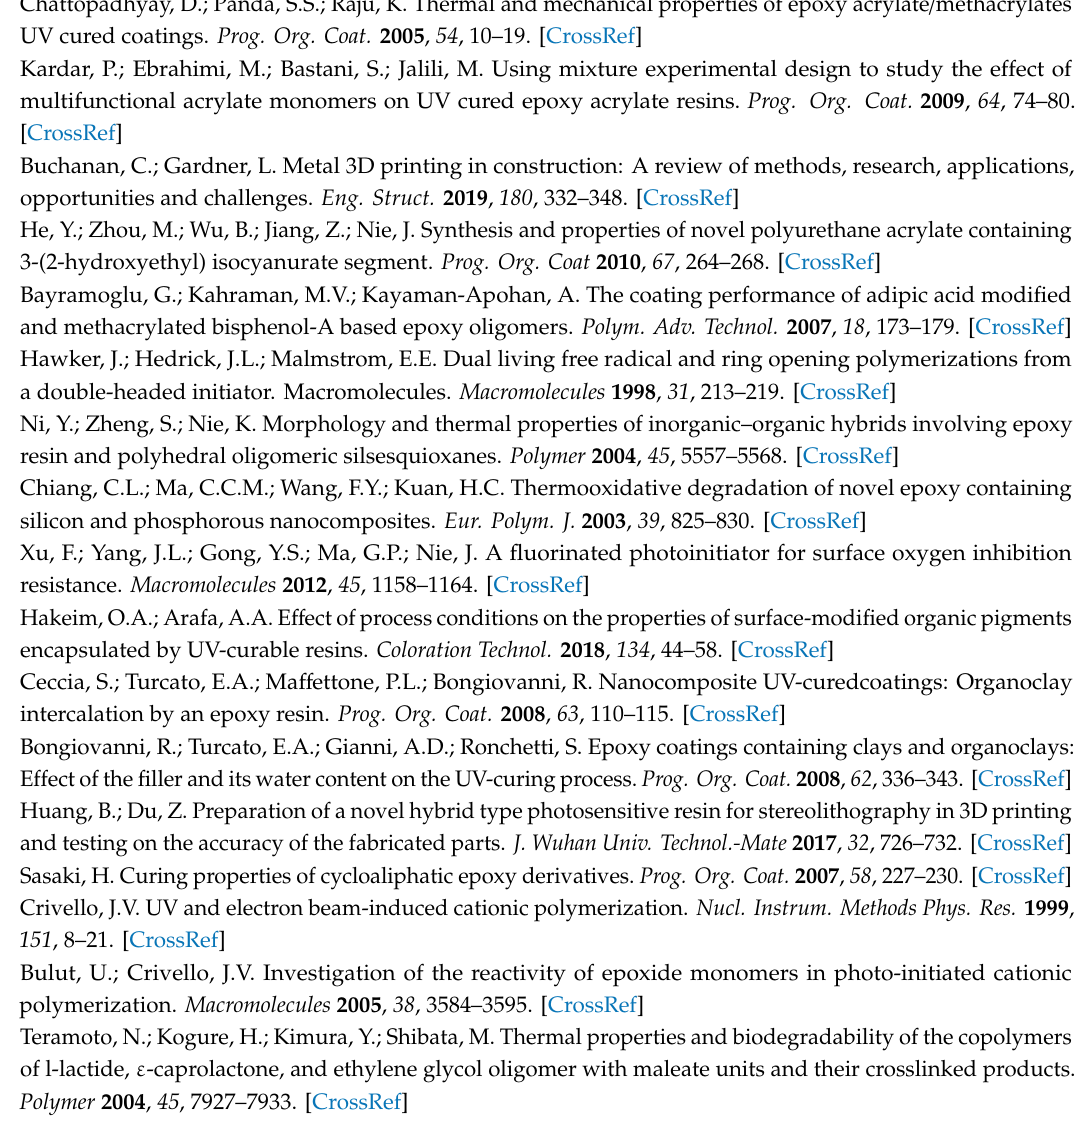
Figure S1 Heat flux maps of the spline at 80 ◦ C; Figure S2 Heat flux maps of the spline at 100 ◦ C; Figure S3 Heat flux maps of the spline at 150 ◦ C; Figure S4 Temperature map of the spline with heat treatment at 80 ◦ C for 22 s; Figure S5 Temperature map of the spline with heat treatment at 100 ◦ C for 22 s; Figure S6 Temperature map of the spline with heat treatment at 150 ◦ C for 22 s; Figure S7 Maximum thermal deformation map of the spline on Y-axis at 80 ◦ C; Figure S8 Maximum thermal deformation map of the spline on Y-axis at 100 ◦ C; Figure S9 Maximum thermal deformation map of the spline on Y-axis at 150 ◦